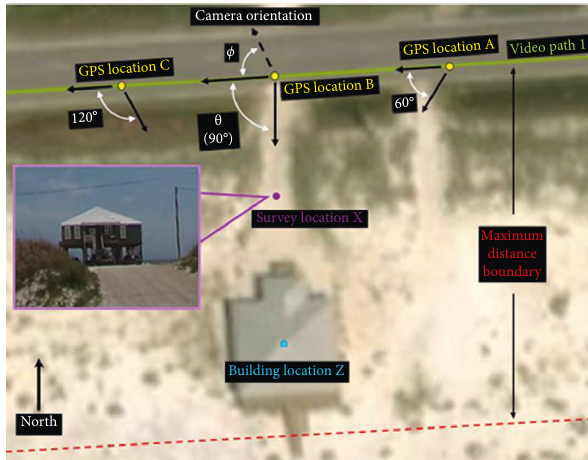
Figure 6: Illustration of the automated image extraction